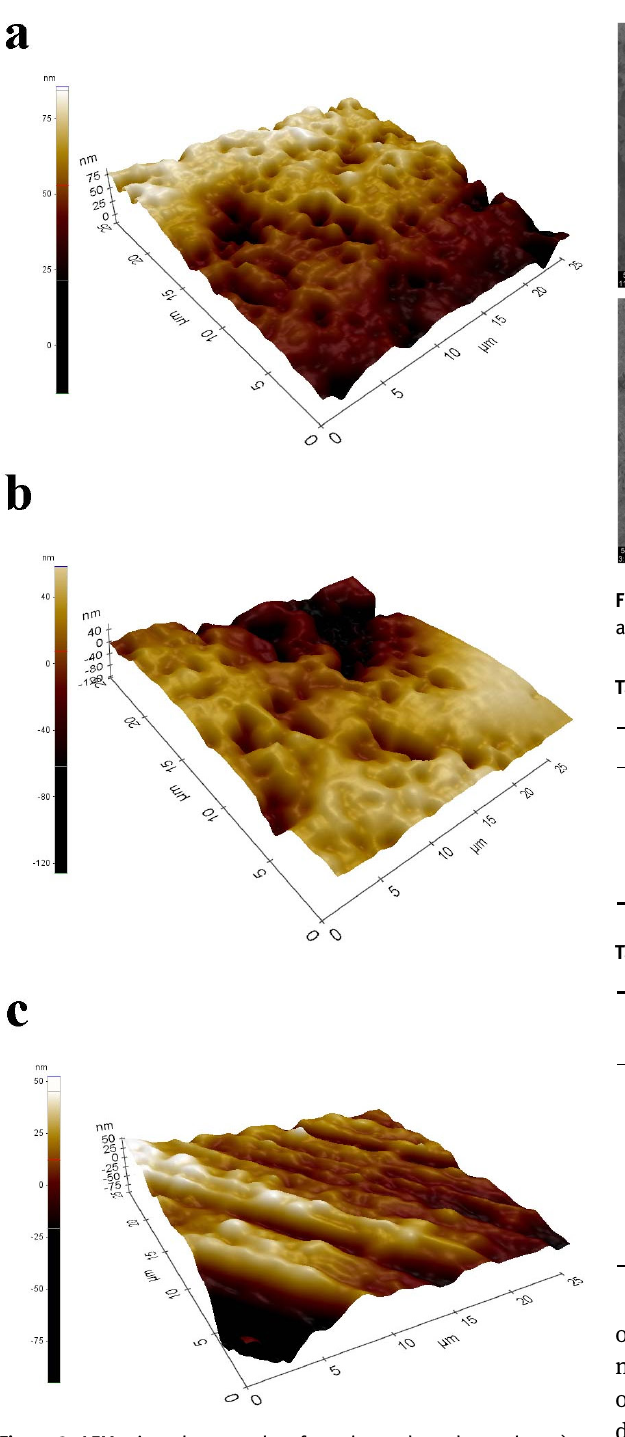
Figure 3: AFM microphotographs of accelerated aged samples: a) 2.5, b) 5 and c) 10 h.